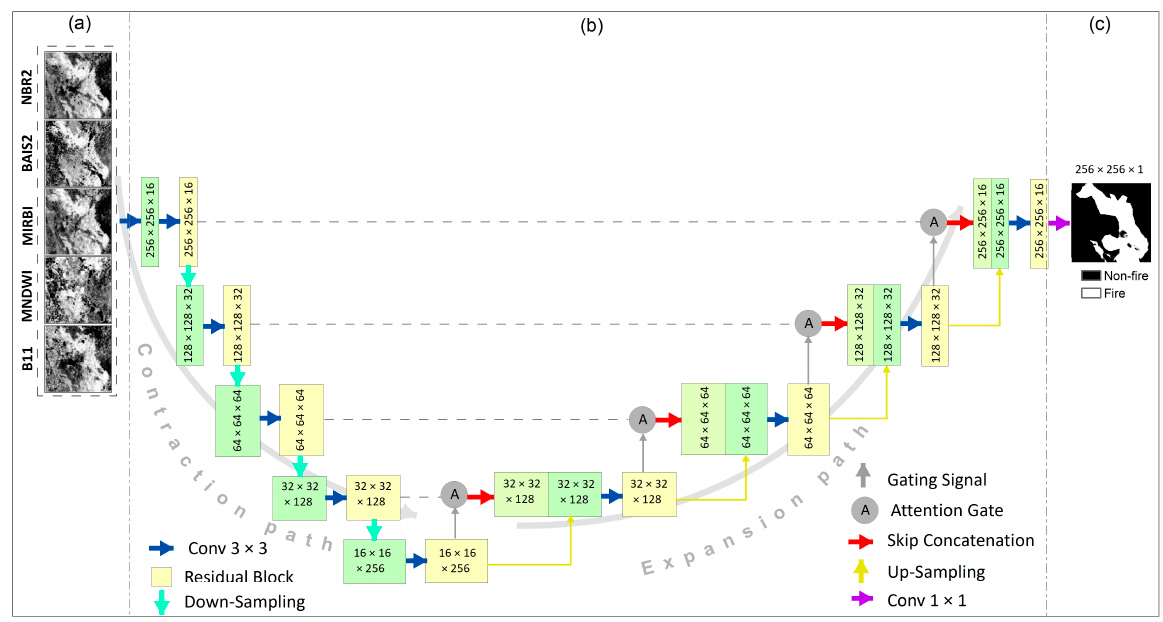
Figure 3. ( b ) Architecture of the projected residual attention UNet (RAUNet), consisting of a con- traction path (encoder) and an expansion path (decoder), using ( a ) the top variables of Sentinel-2 for ( c ) fire segmentation.